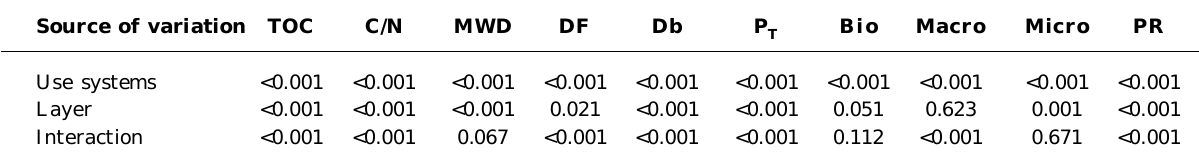
TOC: total organic carbon; C/N: carbon/nitrogen ratio; MWD: mean weight diameter; DF: degree of flocculation; Db: bulk density;